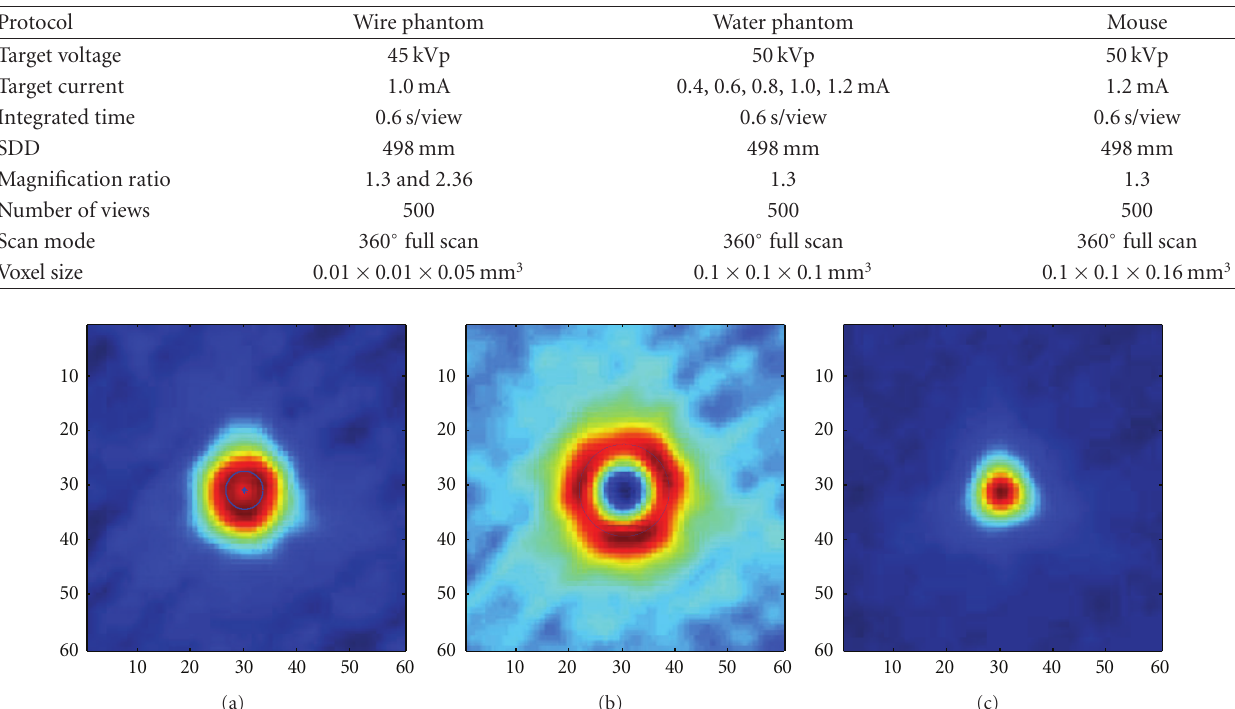
Table 1: Micro-CT scanning protocols for phantoms and mouse.